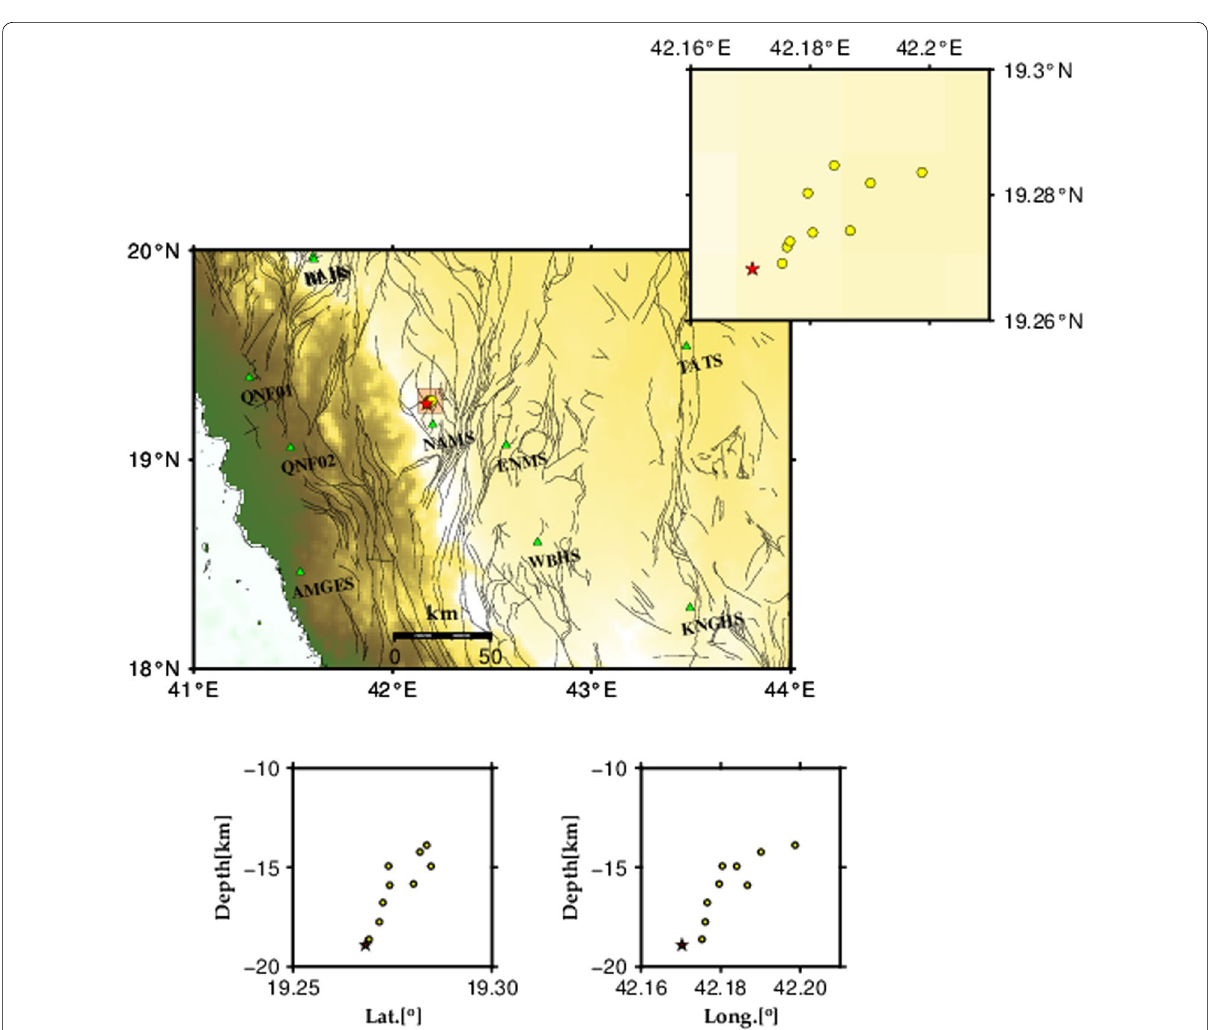
Fig. 3 The upper panel shows the spatial distribution of epicenters of events of moment magnitude ranging from 2.0 to 4.0. The red star refers to the mainshock and the yellow circles correspond to the largest aftershocks. Green triangles show the nearest seismic stations that recorded the events. The map shows also the surface faults represented by thin solid lines as taken from SGS. The upper right panel shows a zoom of epicentral area and the epicenter distributions. The lower panels show the vertical distribution of hypocenters along both latitude and